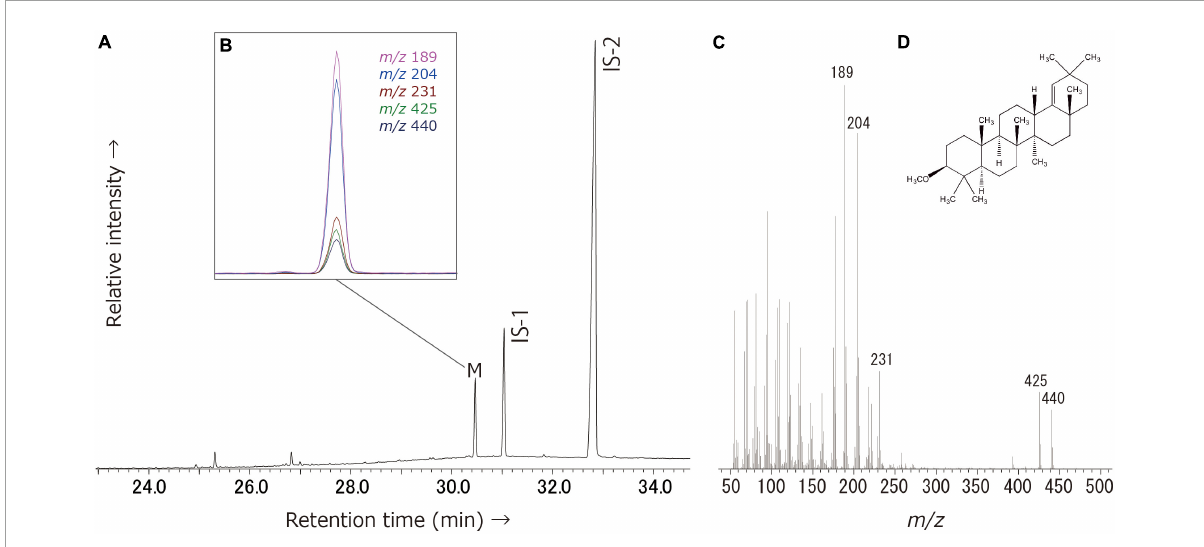
FIGURE4 Typical partial gas chromatogram of the Katartobe potsherd (KAT003ITLE) lipid extract. (A) Partial total-ion chromatogram of the solvent extracts. Peak identities–M, miliacin; IS-1, n -tetratriacontane; IS-2, n -hexatriacontane. (B) The summed m/z ion 189, 204, 231, 425, and 440 chromatograms show the presence of miliacin. (C) Mass spectrum of miliacin detected from the extracts. (D) Chemical structure of miliacin.